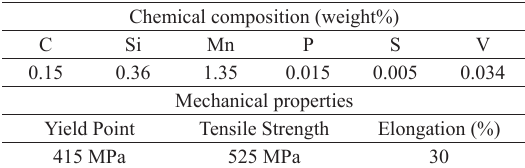
Table 1. Steel chemical composition and mechanical